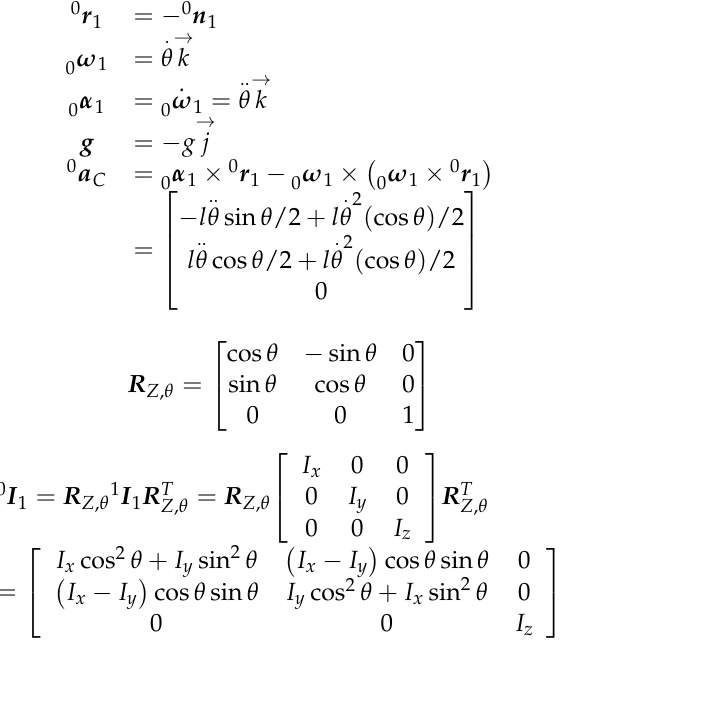
r is the global position of the mass center i